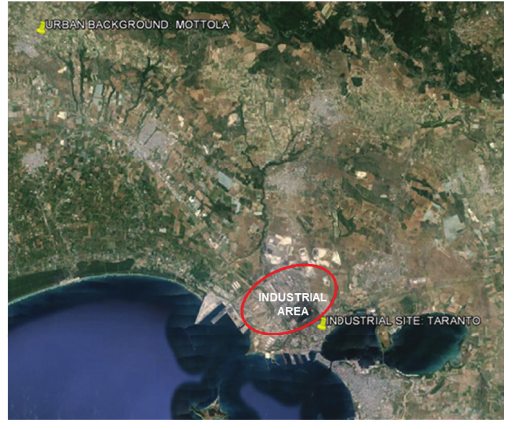
Figure 1: Map of the investigated